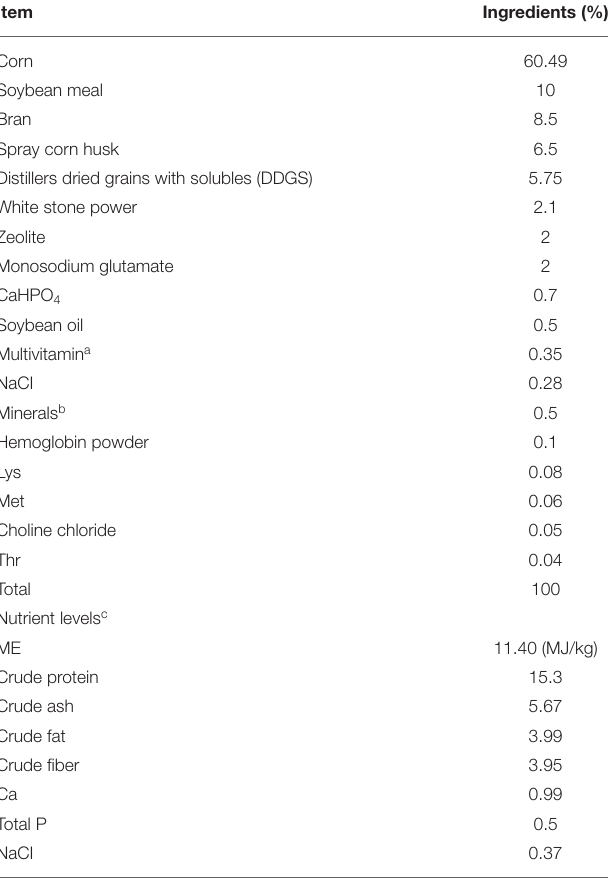
TABLE 1 | Ingredients and nutrient levels of diets used during weeks